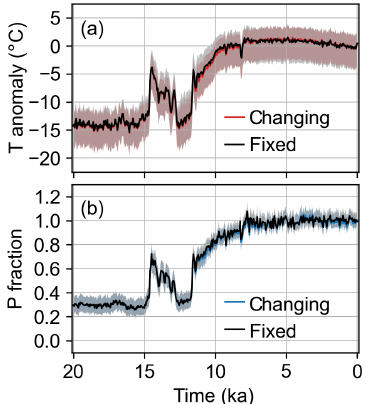
Figure 8. Changing (red and blue) vs. fixed (black) proxy net- work for the (a) temperature ( T ) and (b) precipitation ( P ) reanalysis mean and 5th to 95th percentile shading. Anomalies and fractions are with respect to the mean of 1850–2000 CE. These time series are for the location closest to Summit, which is representative of the results around